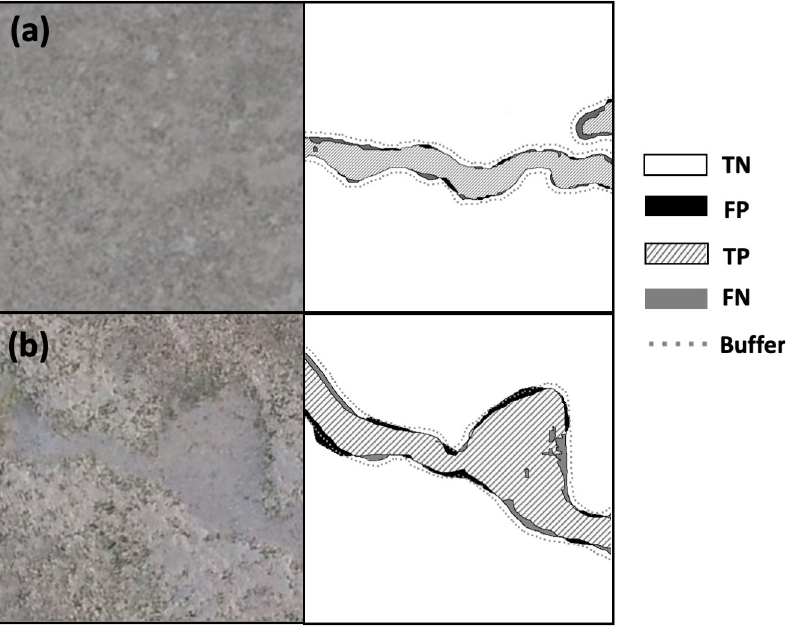
Fig 12. Examples of input (left inset) and extraction (right inset, true negatives TN are in the white area, false positives FP in the black area, true positives TP in the striped area, and false negatives FN in the gray area). The gray dotted line shows the buffer boundaries for the 7 pixels (0.47 cm/pixel) used in this study.